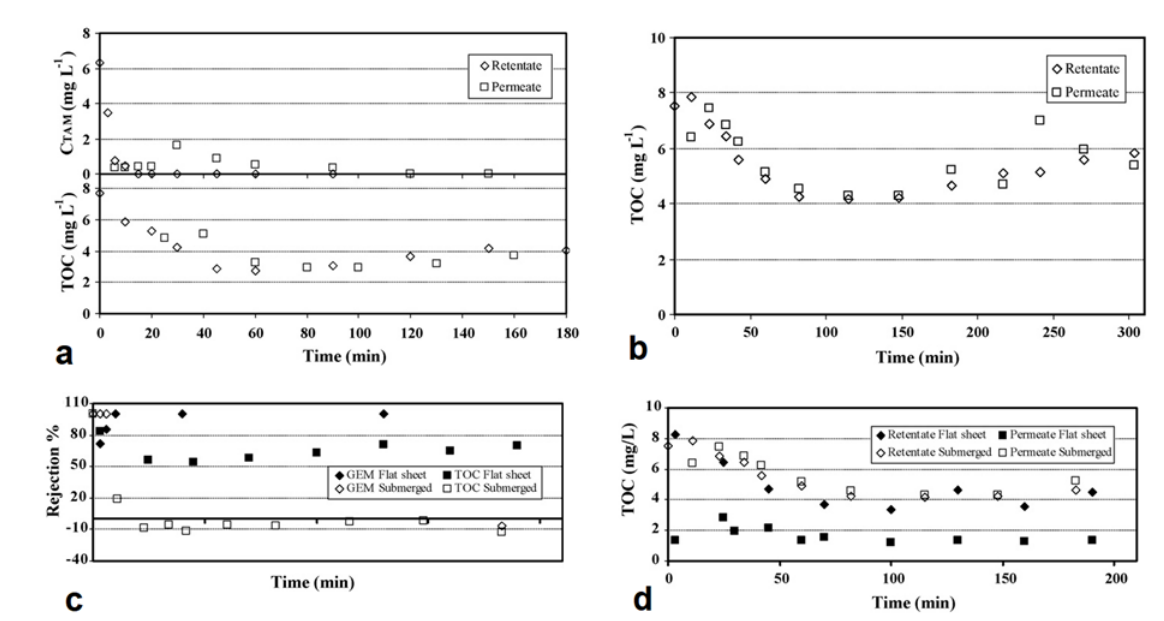
Figure 12. Degradation of drugs as a function of time: ( a ) degradation of citrate tamoxifen (TAM)— TAM concentration (CTAM) and TOC concentration; ( b ) Gemfibrozil (GEM) degradation; ( c ) GEM rejection in pressurized flat sheet membrane photoreactors; ( d ) GEM rejection in de-pressurized flat sheet membrane photoreactors. Reproduced with permission from [211], Copyright 2008